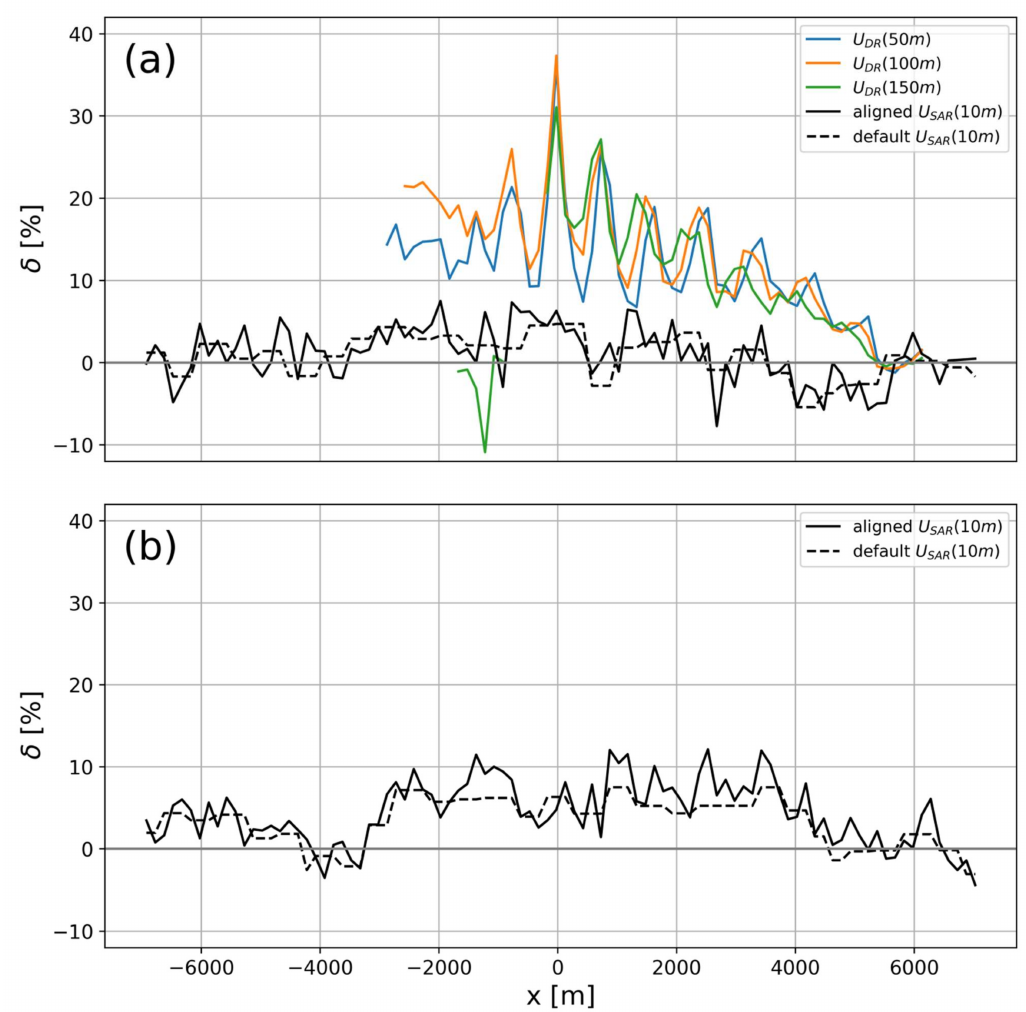
Figure 10. Transects of the velocity deficit for Case 2 at ( a ) 700 m and ( b ) 3700 m downstream. x is defined as the cross-wind distance to turbine location